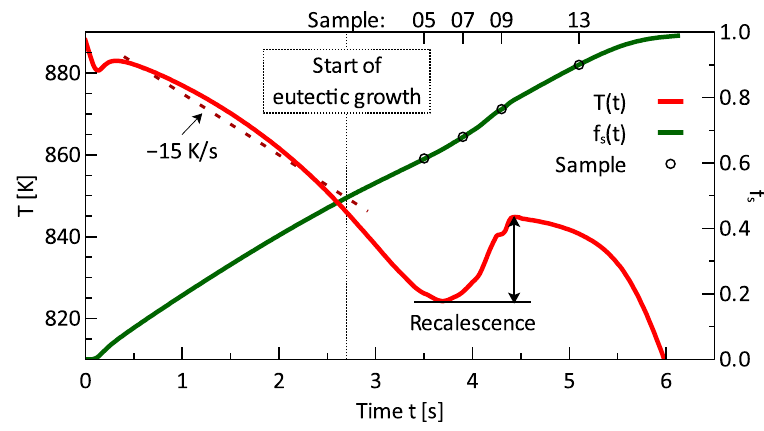
Figure 1. Temperature and solid fraction over time during solidification.